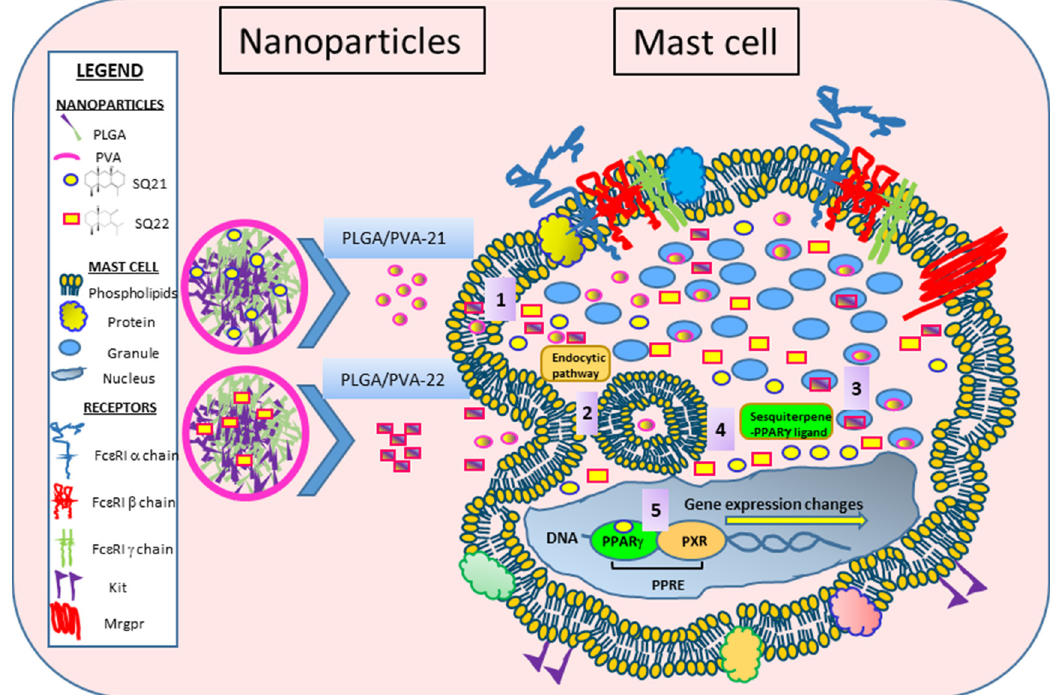
Figure 7. PLGA/PVA-hybrid SQ nanoparticles and cell internalization model. 1. PLGA/PVA-21 or -22 nanoparticles travel directly through the lipid bilayer of the cell membrane. 2. Nanoparticles are taken up by the endocytic pathway. 3. PLGA/PVA is hydrolyzed and SQs are released into the cell cytoplasm as PPAR γ ligands. 4. SQs bind to cell granules. 5. SQs bind to the PPAR γ transcription factor in the nucleus, which, in turn, binds to the retinoic acid-X receptor (RXR), forming the PPRE complex on the DNA and modifies gene expression.